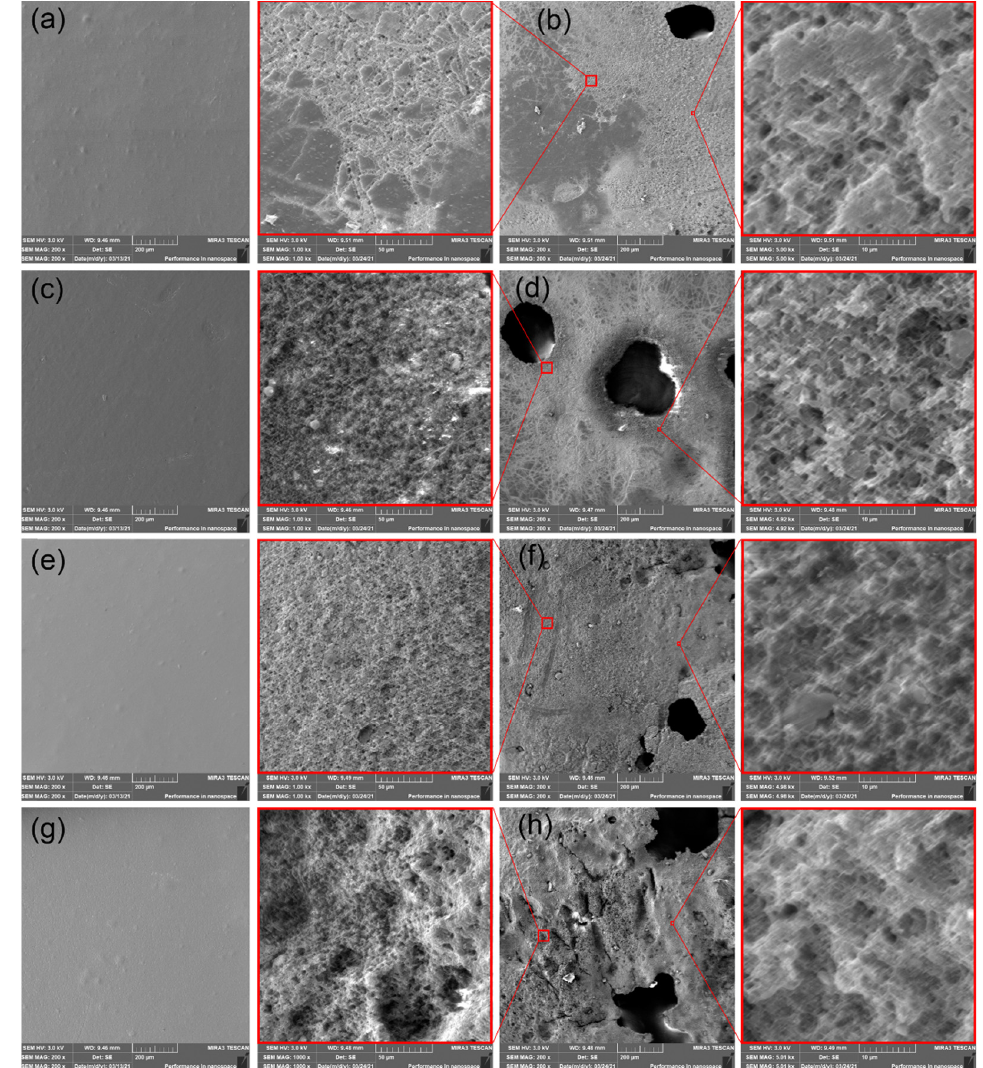
Figure 7. SEM images of ( a ) neat PHBV film at initial state, ( b ) neat PHBV film after 30 days of degradation in thermophilic composting, ( c ) PHBV/ATBC at initial state, ( d ) PHBV/ATBC film after 30 days of degradation in thermophilic composting, ( e ) PHBV/ATBC/L-CNC at initial state, ( f ) PHBV/ATBC/L-CNC film after 30 days of degradation in thermophilic composting, ( g ) PHBV/ATBC/CaCO 3 at initial state, ( h ) PHBV/ATBC/CaCO 3 film after 30 days of degradation in thermophilic composting.